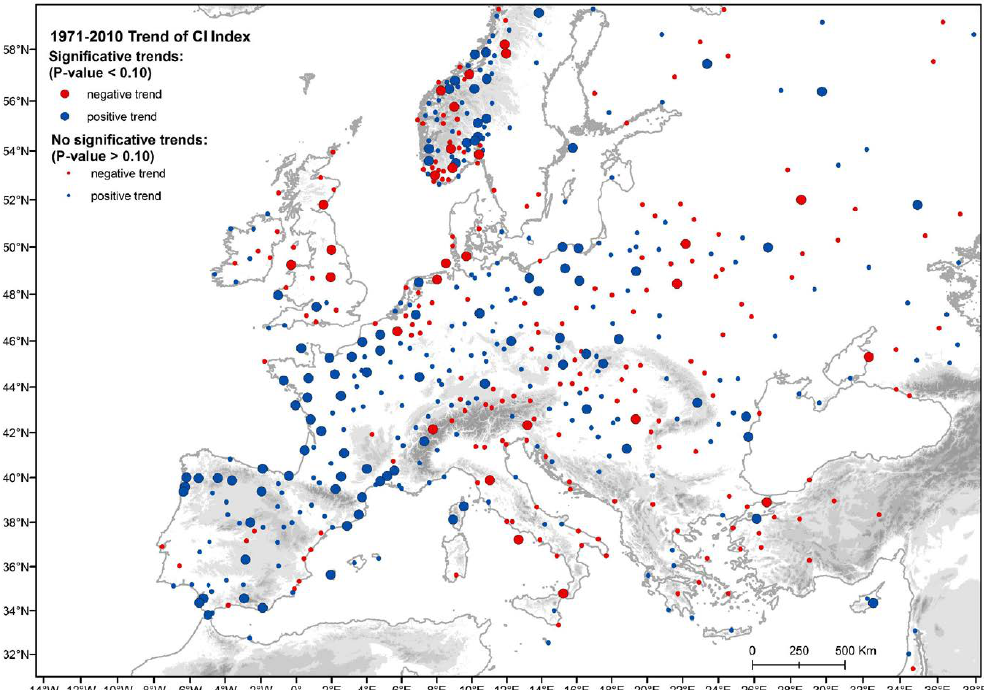
Fig. 9. Winter CI trend distribution (1971–2010). Positive trends are in blue and negative ones in red. Large dots represent significative trends ( p < 0 . 10), otherwise small dots are shown.